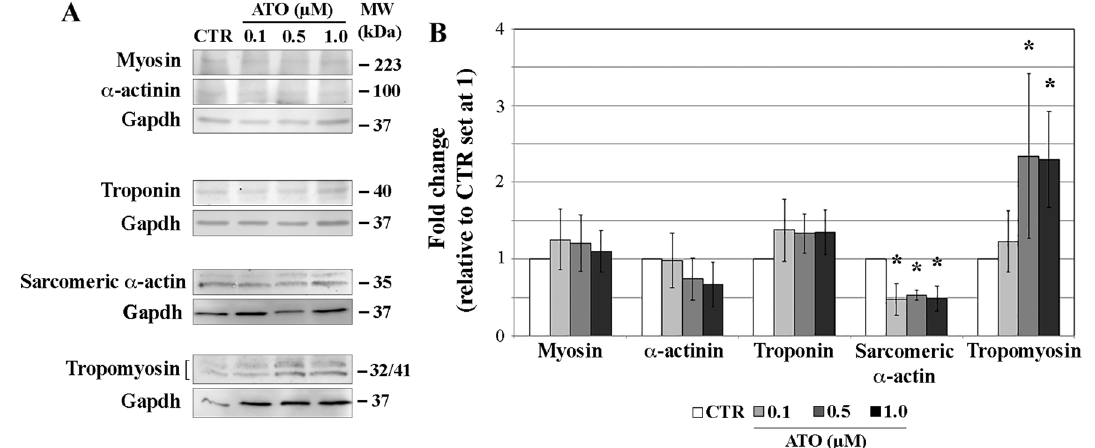
Figure 3. Western blotting analysis of myosin, cardiac α-actinin, troponin, tropomyosin and α-actin sarcomeric proteins ( A ) and the results of their quantitation ( B ). * p < 0.001.